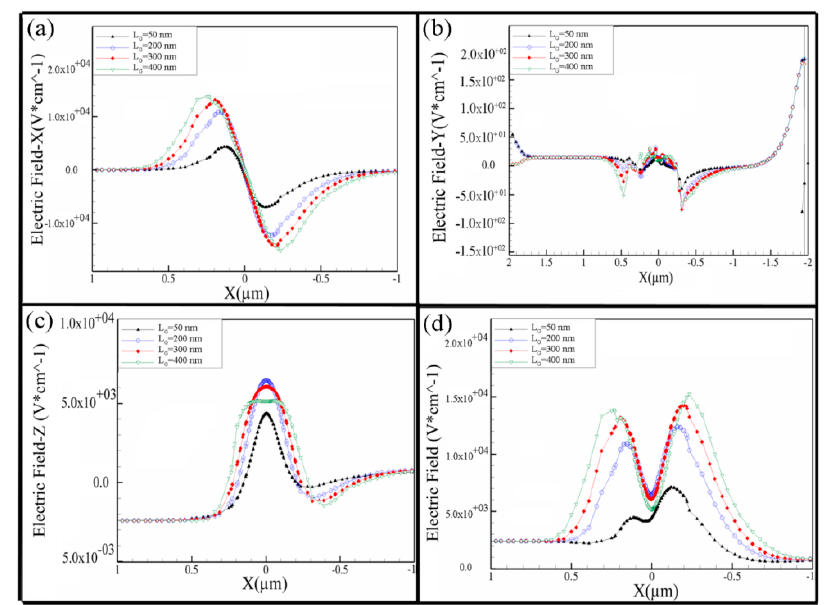
Figure 3. Components of electric field distribution along a horizontal cut line at the center of the channel (Z = 50 nm), ( a ) along X-axis ( b ) along Y-axis ( c ) along Z-axis ( d ) superposition of electric field components.